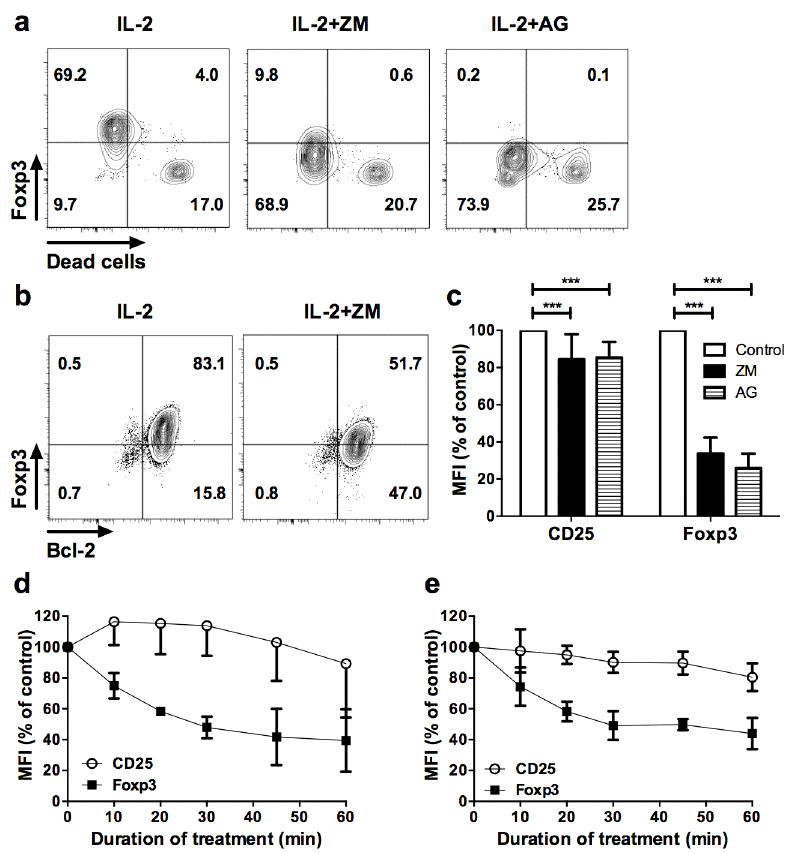
Fig 2. Reduced Foxp3 by JAK/STAT inhibitors is independent of cell death. (a) CD4 + GFP + T cells sorted from Foxp3-GFP transgenic mice were stimulated with anti-CD3/CD28 beads for 8 days and treated with vehicle and IL-2 (IL-2), or IL-2 supplemented with ZM (IL-2+ZM) or AG (IL-2+AG) JAK inhibitors for two hours. Cells were then stained with a dye allowing exclusion of dead cells by flow cytometry compatible with Foxp3 intracellular staining. Profiles are representative of 6 and 7 independent experiments for AG and ZM inhibitors, respectively. (b) Foxp3 and Bcl-2 expression in gated CD4 + CD25 + cells from expanded CD4 + GFP + cells after 2 hour treatment with vehicle control and IL-2 (IL-2) or ZM in presence of IL-2 (IL-2 +ZM). Similar results were observed in 3 independent experiments. (c) Median fluorescence intensity (MFI) of CD25 and Foxp3 in dead cell – excluded subset, represented as percentages of the MFI relative to Foxp3 staining in vehicle control condition (control) after two hours treatment with the indicated inhibitors. The results are compiled from 6 (AG) and 7 (ZM) independent experiments. (d) Freshly isolated or (e) anti-CD3/ CD28 activated CD4 + GFP + cells from Foxp3-eGFP reporter mice were treated for the indicated times with either ZM or AG inhibitors. MFI of CD25 and Foxp3 are relative to the MFI of vehicle control conditions. These data are compiled from 3 independent experiments. Statistical significance was tested using Student